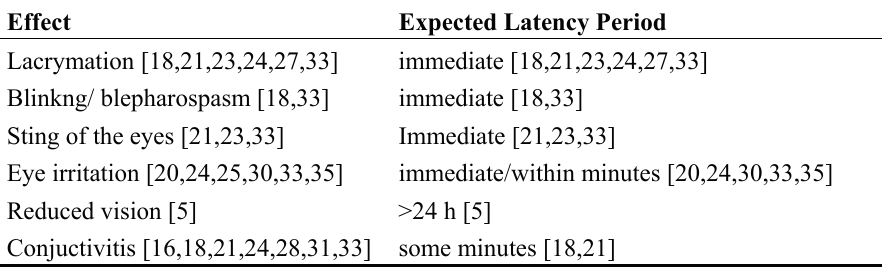
Table 5. Ocular clinical effects and latency